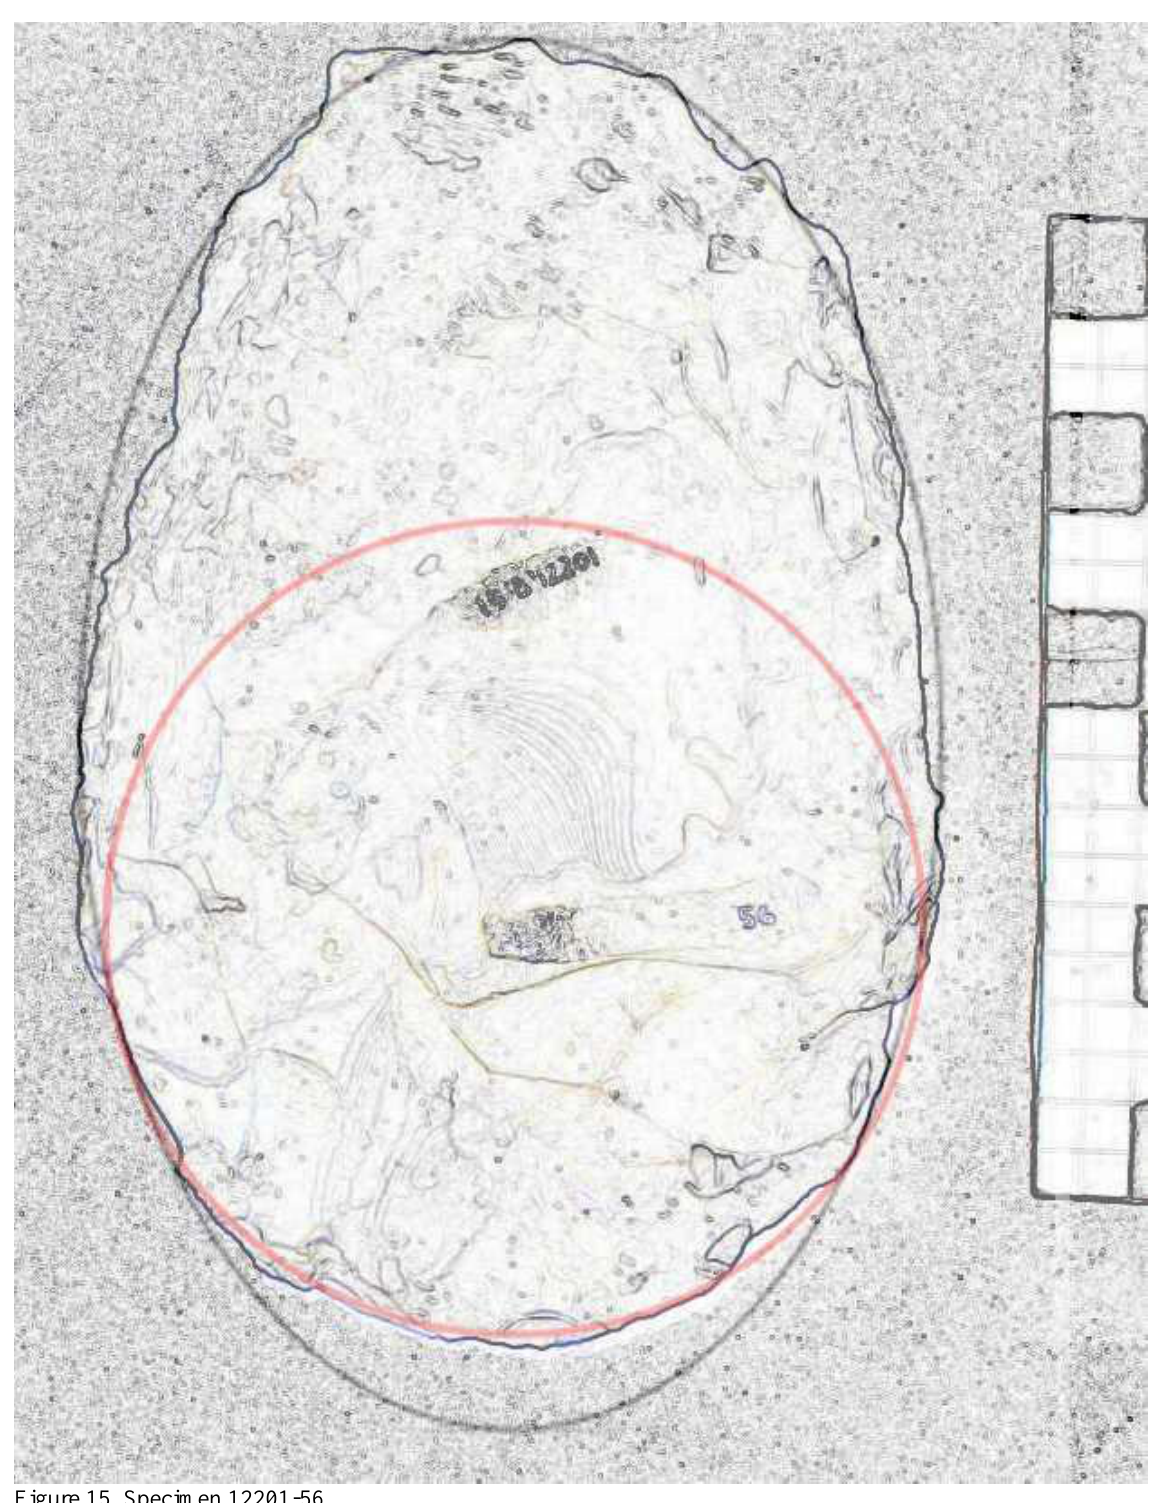
Figure 15. Specimen